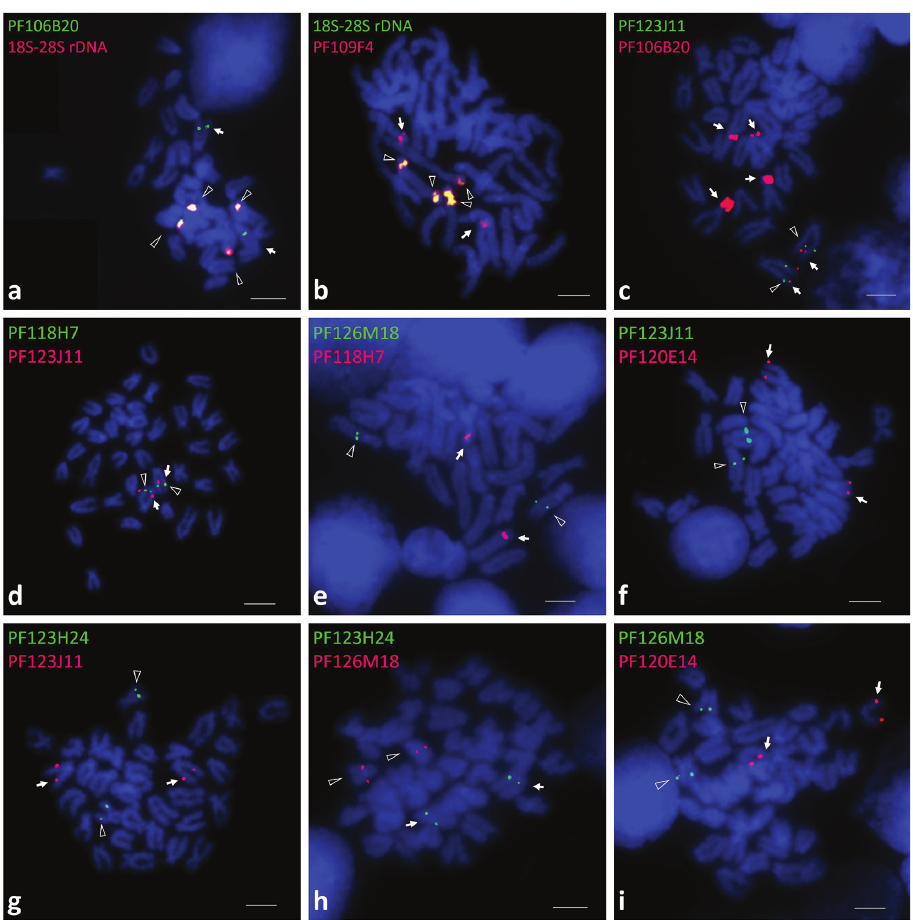
Figure 2. Co-hybridization results of fosmid clones with positive signals on mitotic metaphase chro- mosomes of P. yessoensis (A-I): Mapping of clone PF106B20 & 18S-28S rDNA ( A ), clone PF109F4 &18S-28S rDNA ( B ), clones PF123J11 & PF106B20 ( C ), clones PF118H7 & PF123J11 ( D ), clones PF126M18 & PF118H7 ( E ), clones PF123J11 & PF120E14 ( F ), clones PF123H24 & PF123J11 ( G ), clones PF123H24 & PF126M18 (H), clones PF126M18 & PF120E14 (I). The arrows and the open triangles indicate positive signals of different probes. Bars=10